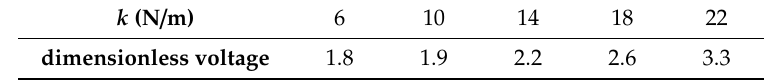
Table 2. Corresponding relationship between the dimensionless voltage and the effective spring, k .